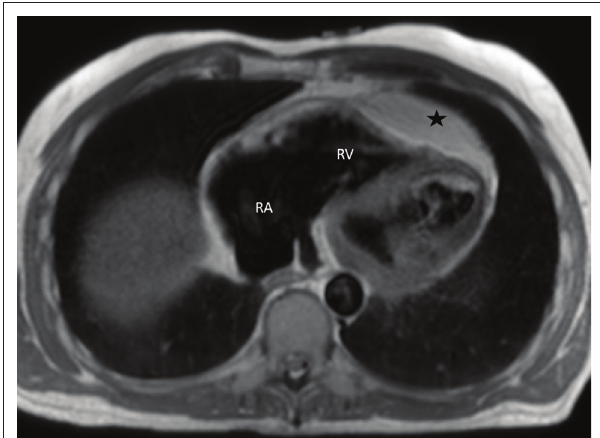
FIGURE 8: A 33-year-old man with liposarcoma of the pericardium. The axial black blood image demonstrates a large hyper-intense mass arising from the pericardium adjacent to the right ventricle (black star).